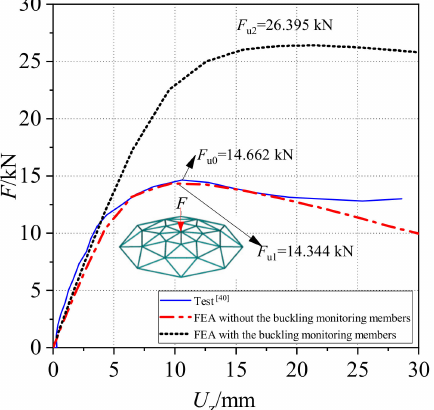
Figure 26. F versus U z relationship of the reticulated shell.